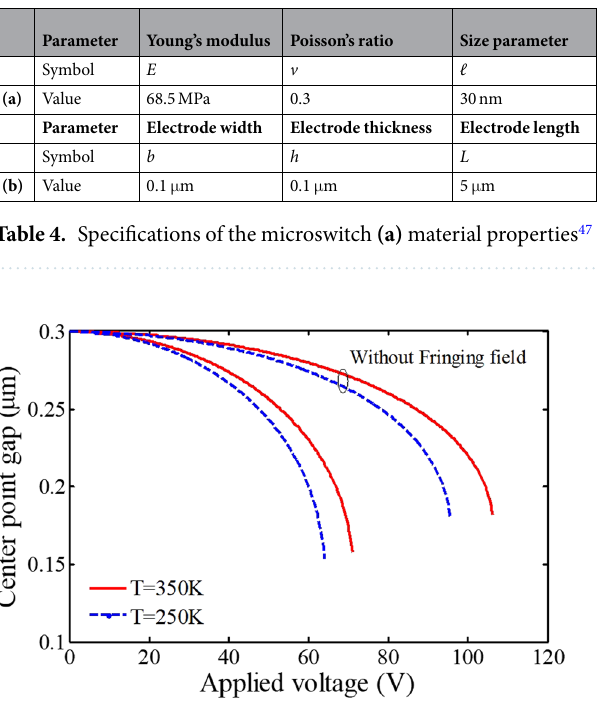
Figure 2. The impact of fringing correction on the sensor behavior at different